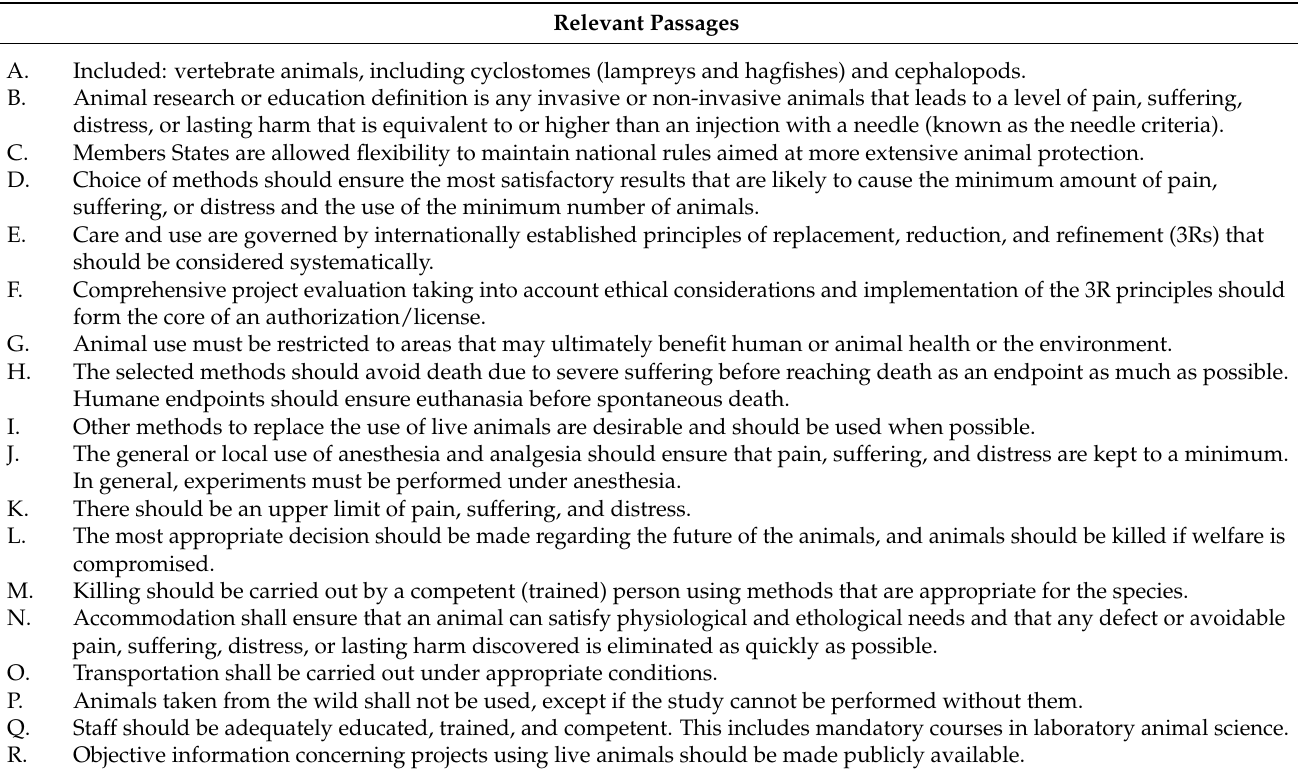
Table 2. Main regulations extracted from the E.U. Directive 2010/63/EU that are of relevance to